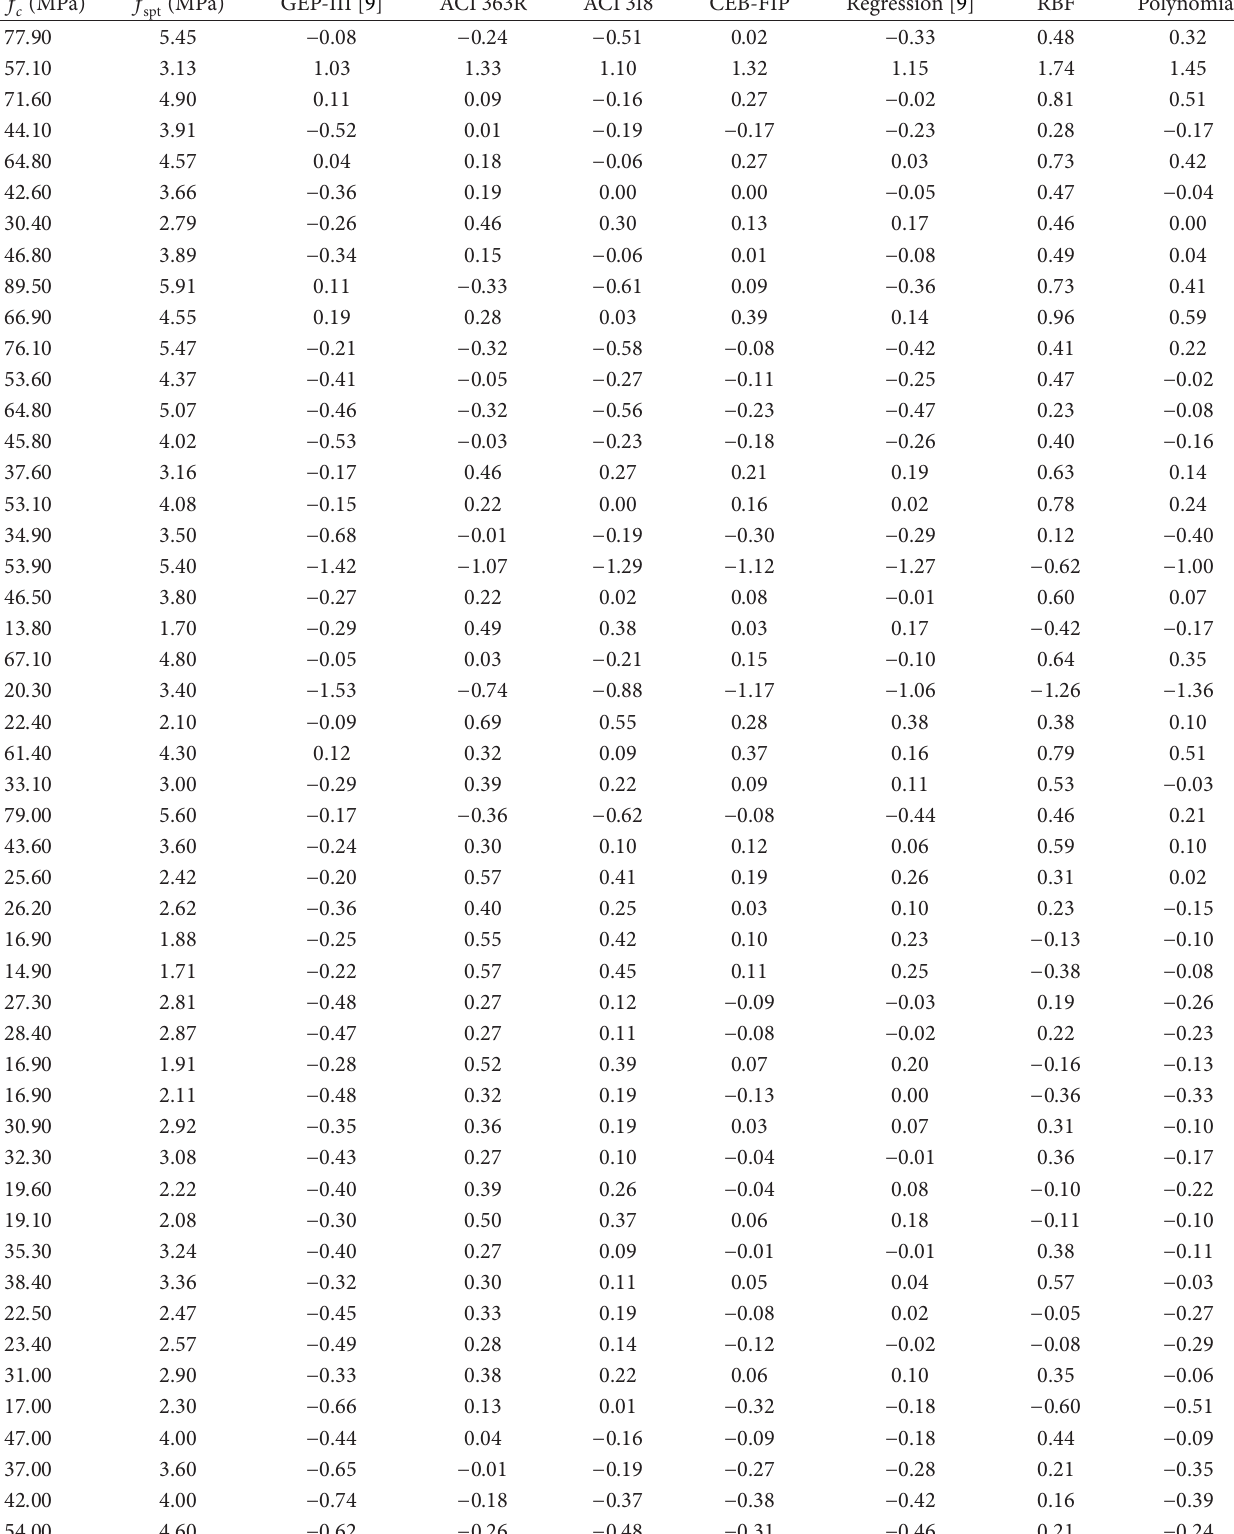
Table 4: Comparison of experimental results to training results of RBF, polynomial of SVM-II, and other